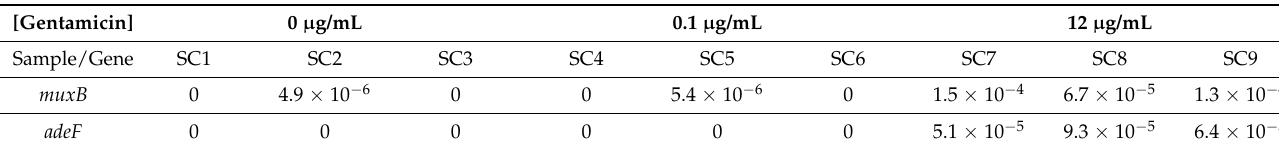
Table 1. Antibiotic-resistance genes (ARGs) that increased their average relative abundance in soil enrichments in 1:10 TSB medium with different gentamicin concentrations after 24 h of incubation (Pearson coefficient > 0.9). Both genes showed a significantly higher abundance at 12 µg/mL of gentamicin compared to the rest of culture enrichments ( p -values of 0.046 and 0.032 for muxB and adeF , respectively).